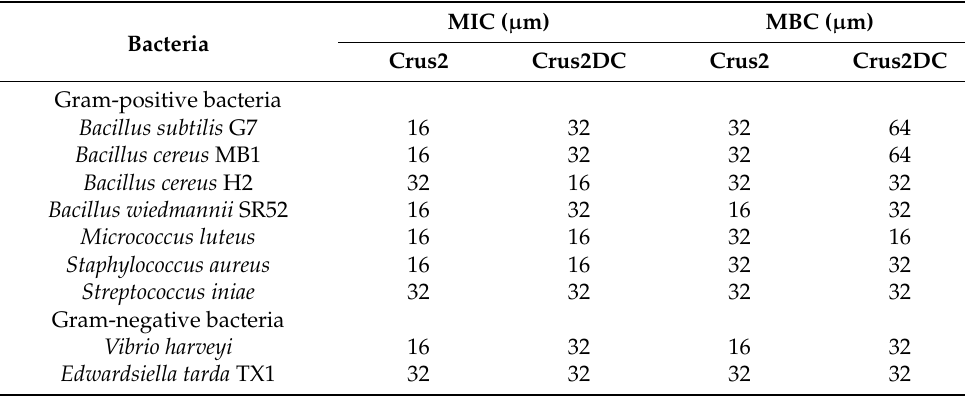
Figure 1. Crus2 sequence and structure. ( A ) The Crus2 sequence was aligned with that of Type I crustins. Dots indicate gaps. Red color indicates consensus residues. Blue color indicates ≥ 75% identity. The WAP domain and the C-terminal region are boxed with red and green lines, respectively. ( B ) Phylogenetic analysis of Crus2. The numbers indicate bootstrap values based on 1000 replications. The asterisk represents the crustin of this study. In ( A , B ), the crustin names are followed by their respective GenBank accession numbers. ( C ) The predicted structures of Crus2 and Crus2DC. The disulfide bonds are shown in yellow (C60–C92), green (C67–C96), blue (C79–C91), and pink (C85–C102). ( D ) The surface electrostatic potential of Crus2 and Crus2DC. 2.2. Crus2 Binds and Kills Gram-Positive and Gram-Negative Bacteria in a Manner That Is Affected in Degree by the C-Terminal P58 Region Table 1. The MIC and MBC of Crus2 and Crus2DC against different